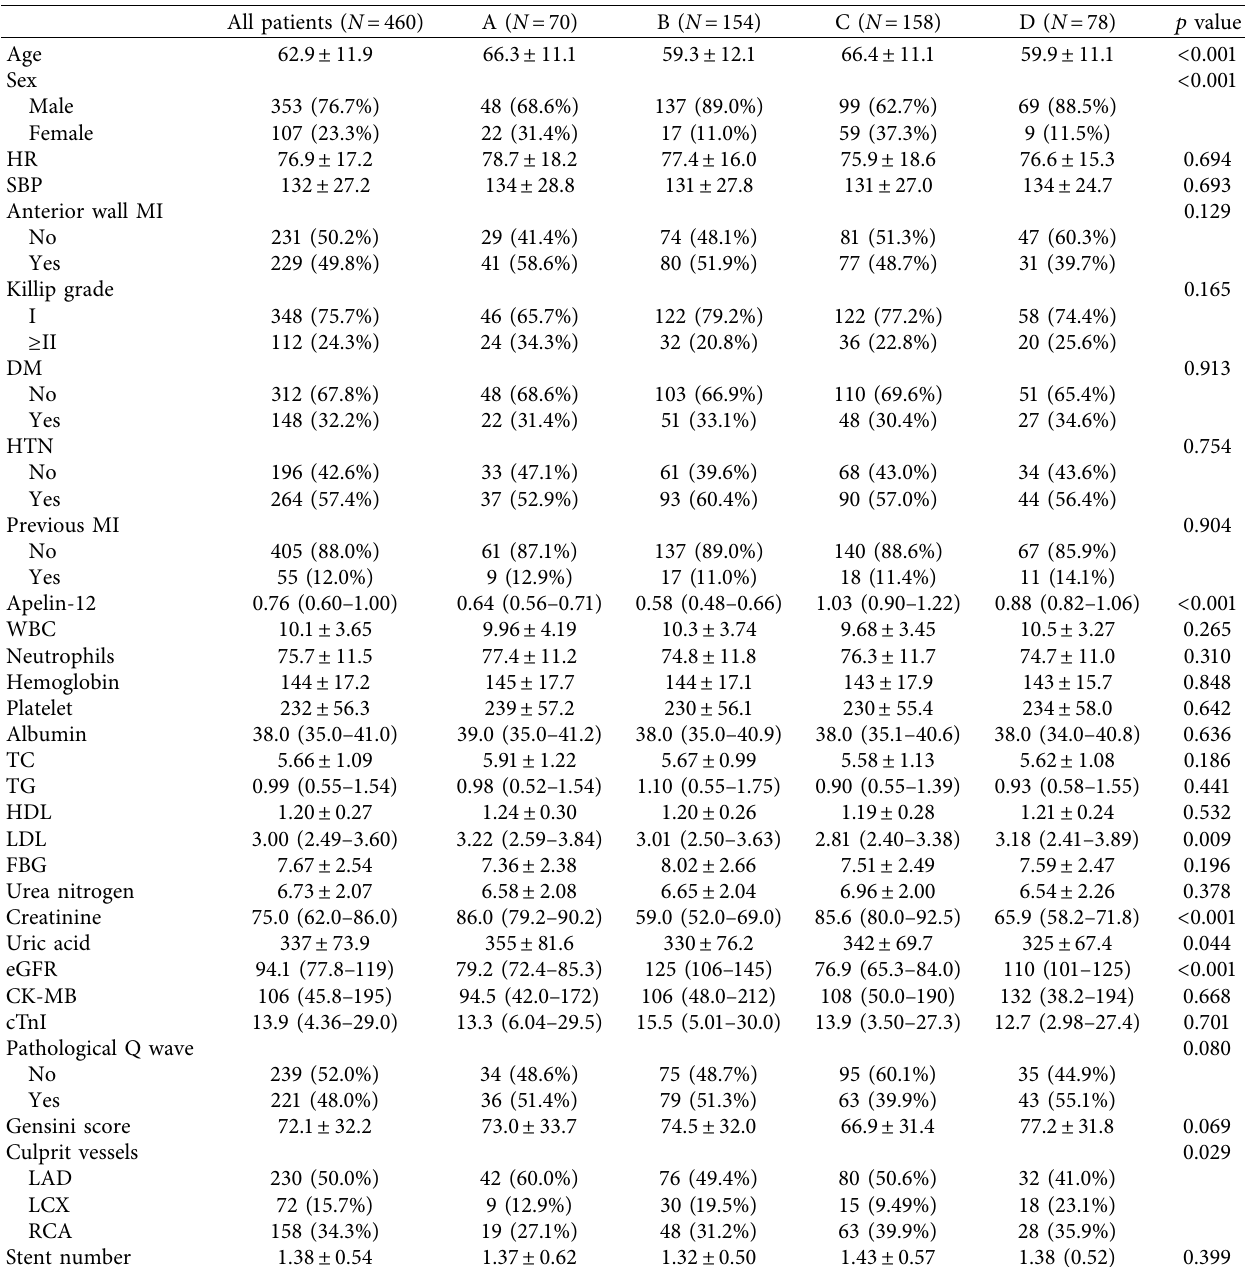
Table 1: Characteristics of